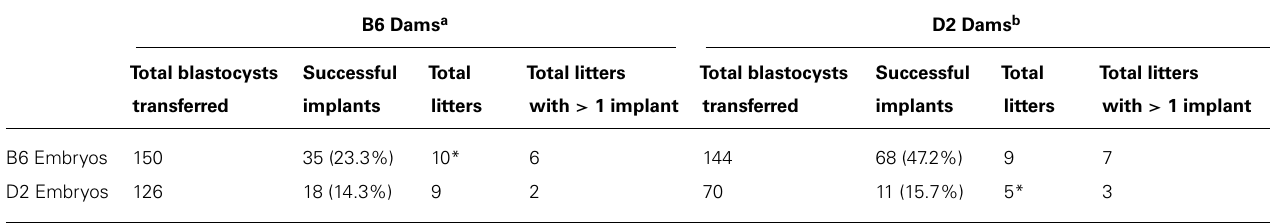
Table 1 | Embryo transfer and implantation success